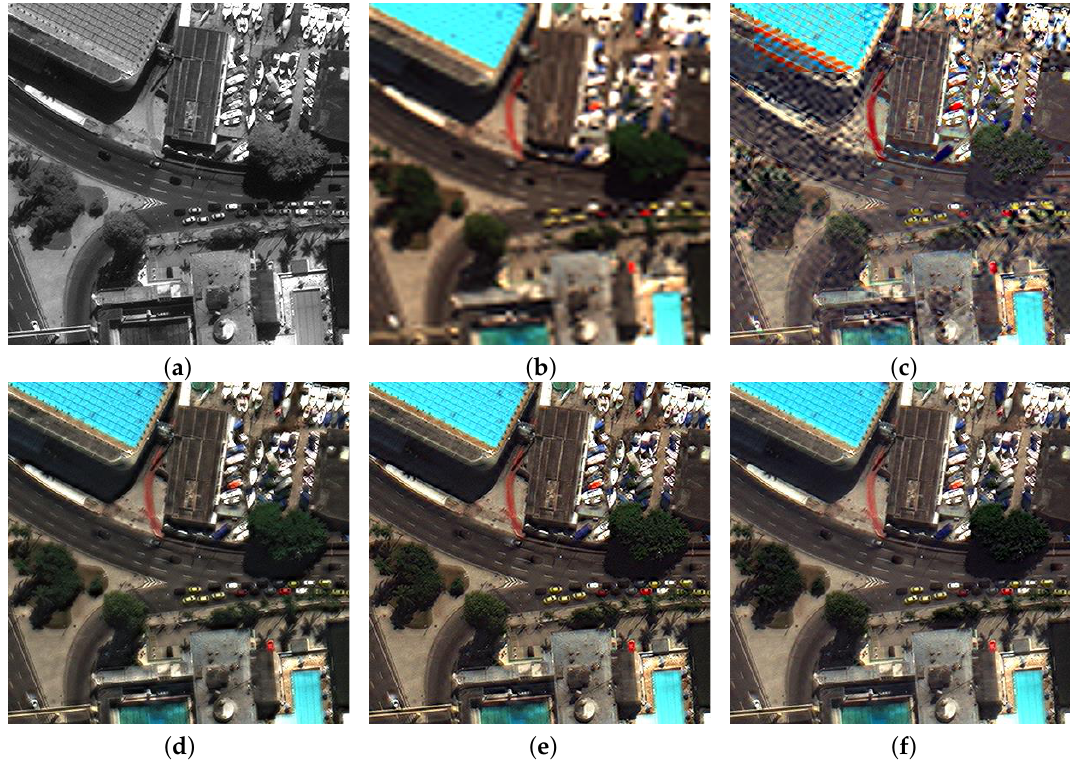
Figure 10. Visualization of WorldView-3 test images: ( a ) PAN; ( b ) MS; ( c ) BDSD; ( d ) MTF-GLP-HPM- PP; ( e ) PanNet; ( f )